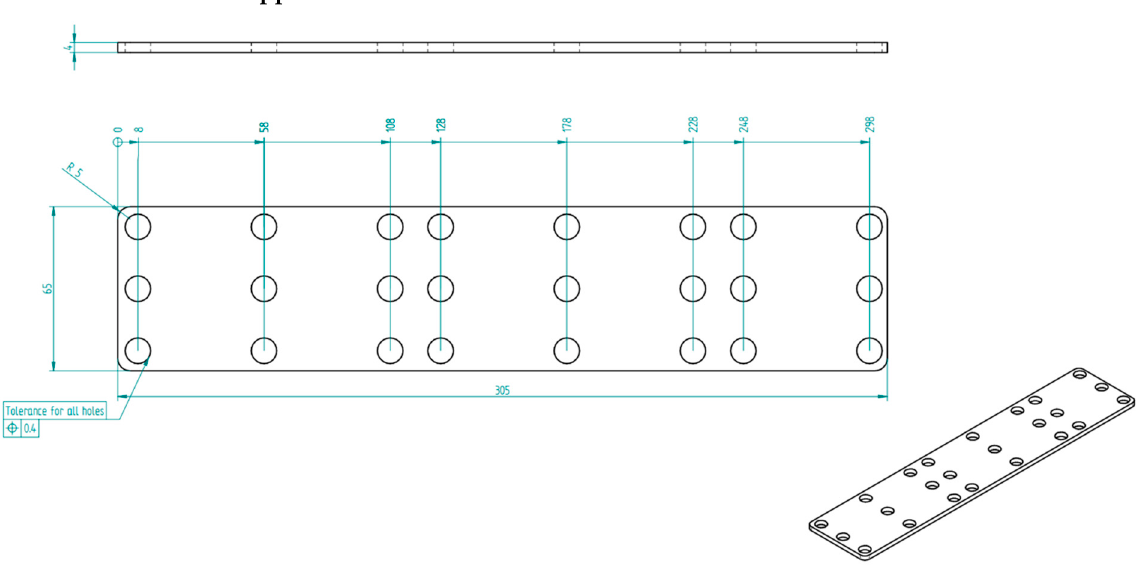
Figure A1. Construction drawing of the 3D printing template for standardized marker bases instru- mentation on the ski. The material that was used was PLA